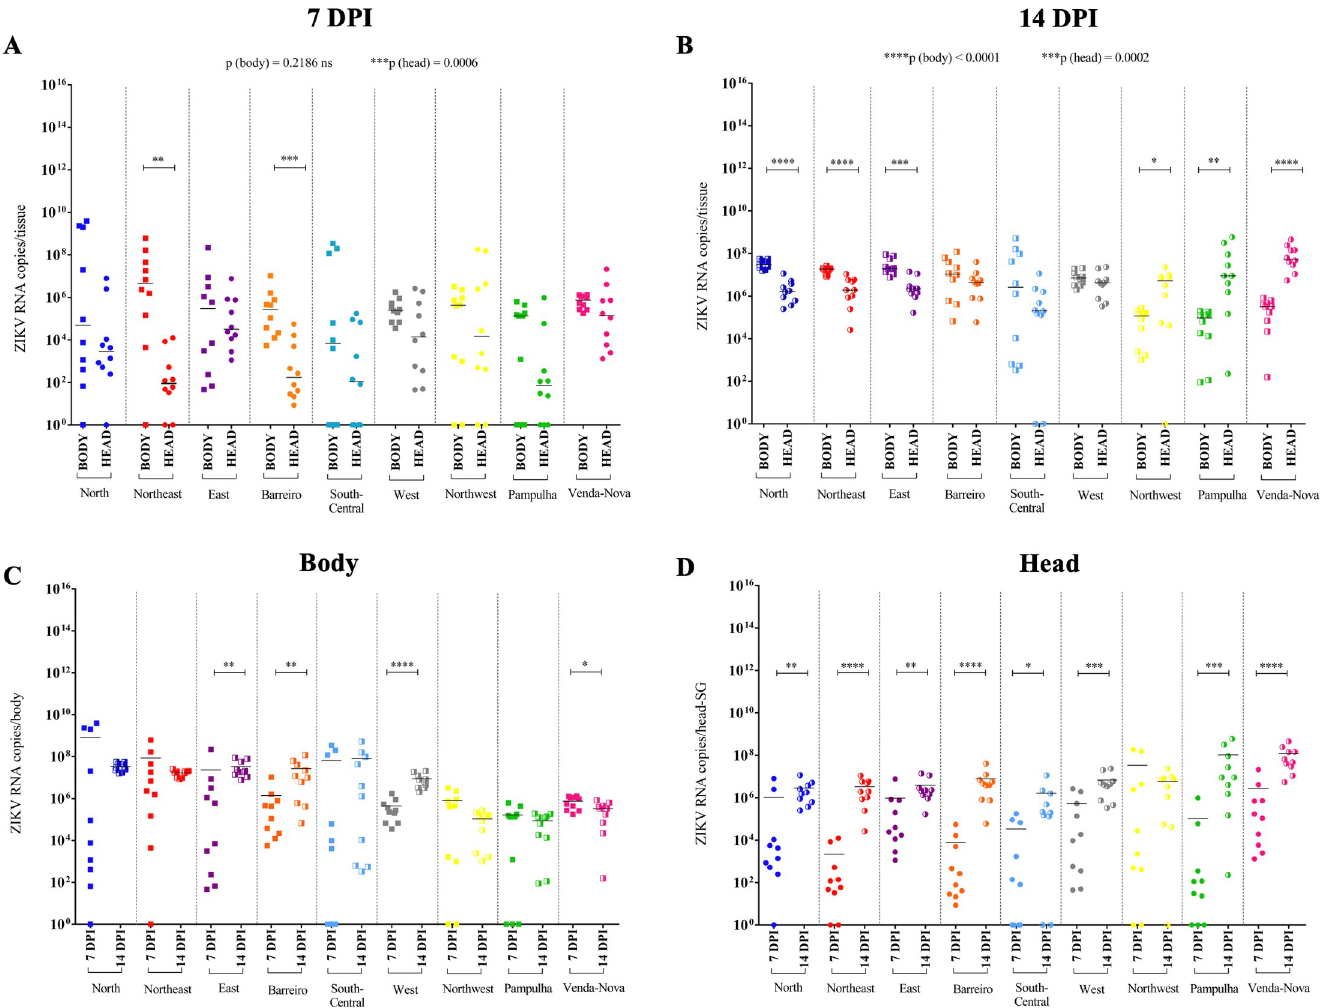
Fig 4. ZIKV viral load per body and head/salivary gland (SG) of Ae . aegypti at 7 and 14 days post-infection (dpi). A : ZIKV viral load per body and head/SG at 7 dpi in Ae . aegypti females from each district of Belo Horizonte. Each dot represents a tested female . B : ZIKV viral load per body and head/SG at 14 dpi in A . aegypti females from each district of Belo Horizonte. Each dot represents a tested female. C-D: Representation of the previous data (A-B) in another layout model to highlight the differences in ZIKV viral load between 7 and 14 dpi in the body ( C ) and head/SG ( D ) of the Ae . aegypti mosquitoes from each of the nine populations of Belo Horizonte. Fully filled and half-filled squares represent viral load in the mosquito bodies at 7 and 14 dpi, respectively. Fully filled and half-filled circles represent viral load in the mosquito head/SG at 7 and 14 dpi, respectively. P values > 0.05 (not significative) are not represented. P values � 0.05, � 0.01, � 0.001, � 0.0001 are summarized with one, two, three, and four asterisks,